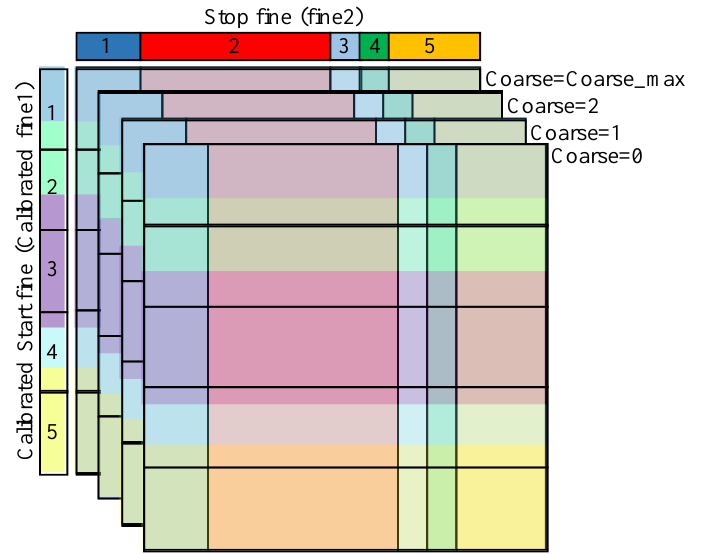
Figure 10. Column calibration, the individual calibration of the columns using the average-bin-width method gives a semi-calibrated histogram where all the rows have the same height. 3. Step 3: Row calibration.